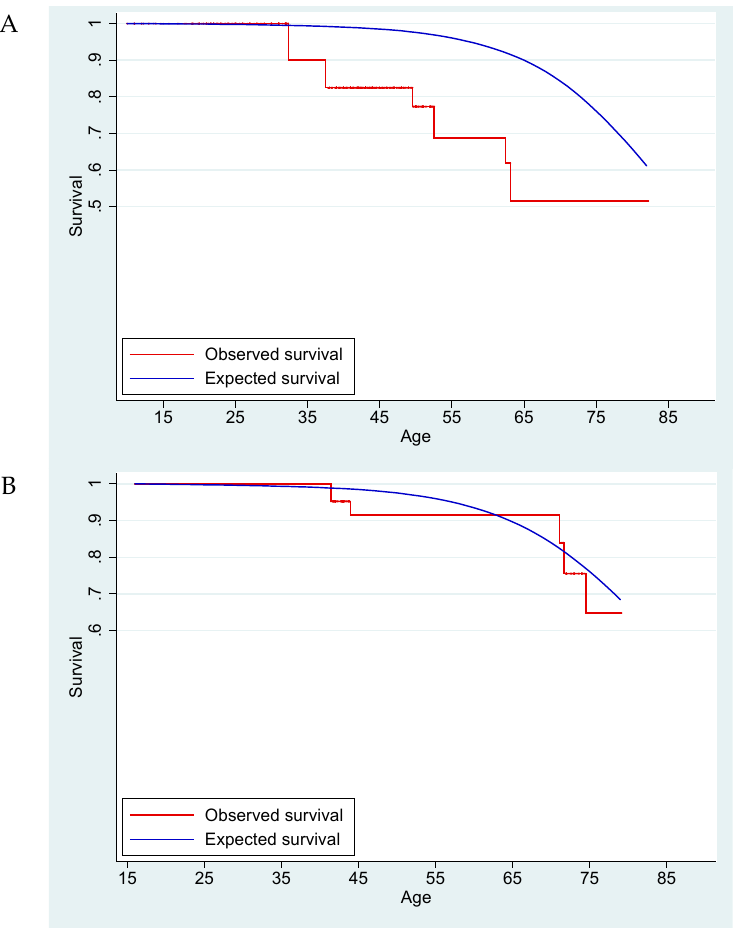
Figure 1. The Kaplan–Meier survival curve for SDHB variant carriers ( A ) and SDHD variant carriers ( B ) compared with the expected survival based on the general Dutch population.